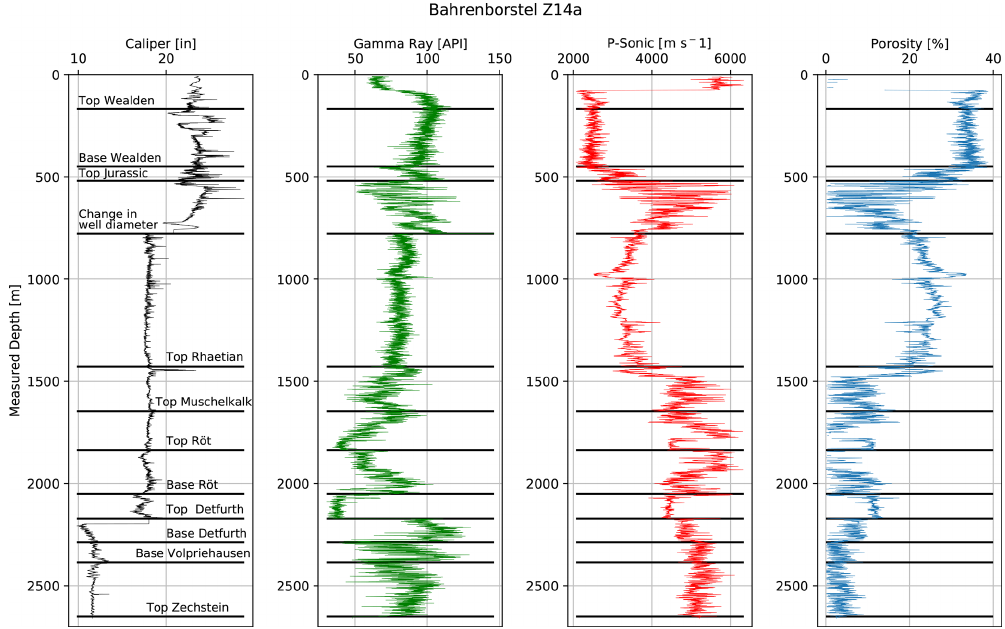
Figure 3. Well logs for the well Bahrenborstel Z14a, one of the usable data sets provided by LBEG in 2022. Negative porosities were omitted. Reservoir parameters were obtained from these logs. Stratigraphic boundaries were extracted from publicly available data of the well Bahrenborstel Z14. Table 1. DoubletCalc parametrization for the Keuper and Middle Bunter